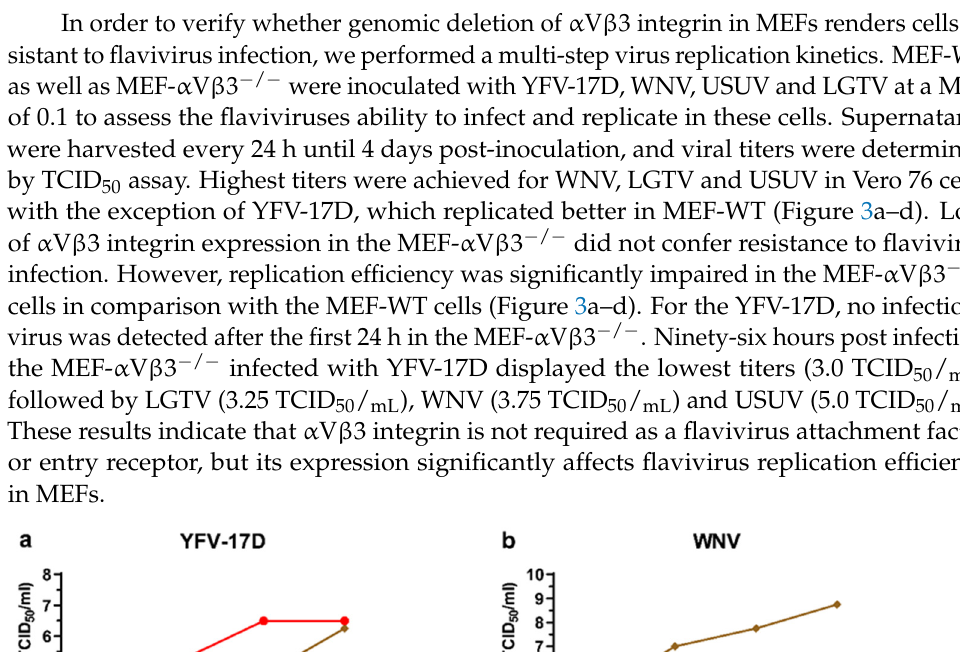
Figure 3. Replication kinetics of ( a ) YFV-17D, ( b ) WNV, ( c ) USUV and ( d ) LGTV in MEF-WT, MEF- α V β 3 − / − and Vero 76 cells. Cells were inoculated with these flaviviruses at a MOI of 0.1 and supernatants were harvested at 24, 48, 72 and 96 h post inoculation. Values represent virus titers determined by TCID 50 in Vero 76 cells over a period of 4 days post-infection. 3.4. Absence of α V β 3 Integrin Expression Affects Internalization of Some but not All Flaviviruses Integrins promote a close connection with the actin cytoskeleton leading to a sequence of intracellular events that later culminate in remodeling of actin filaments and consequently cell membrane reorganization [48,49]. Flavivirus internalization is mediated